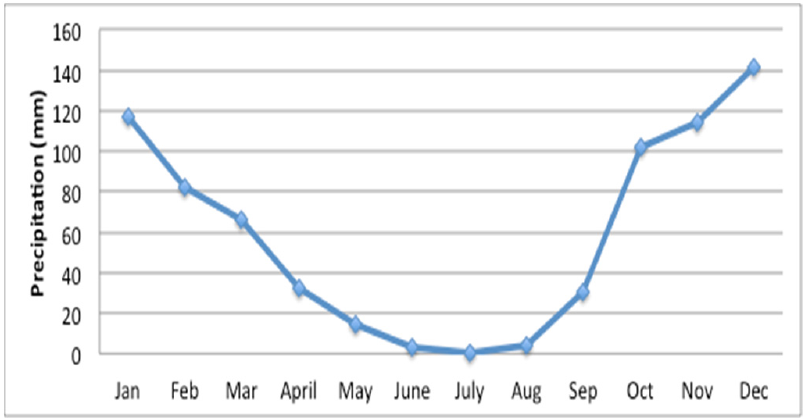
Figure 6. Monthly precipitation at Methoni, Peloponnese (data source: Hellenic National Meteoro- logical Service-HNMS).